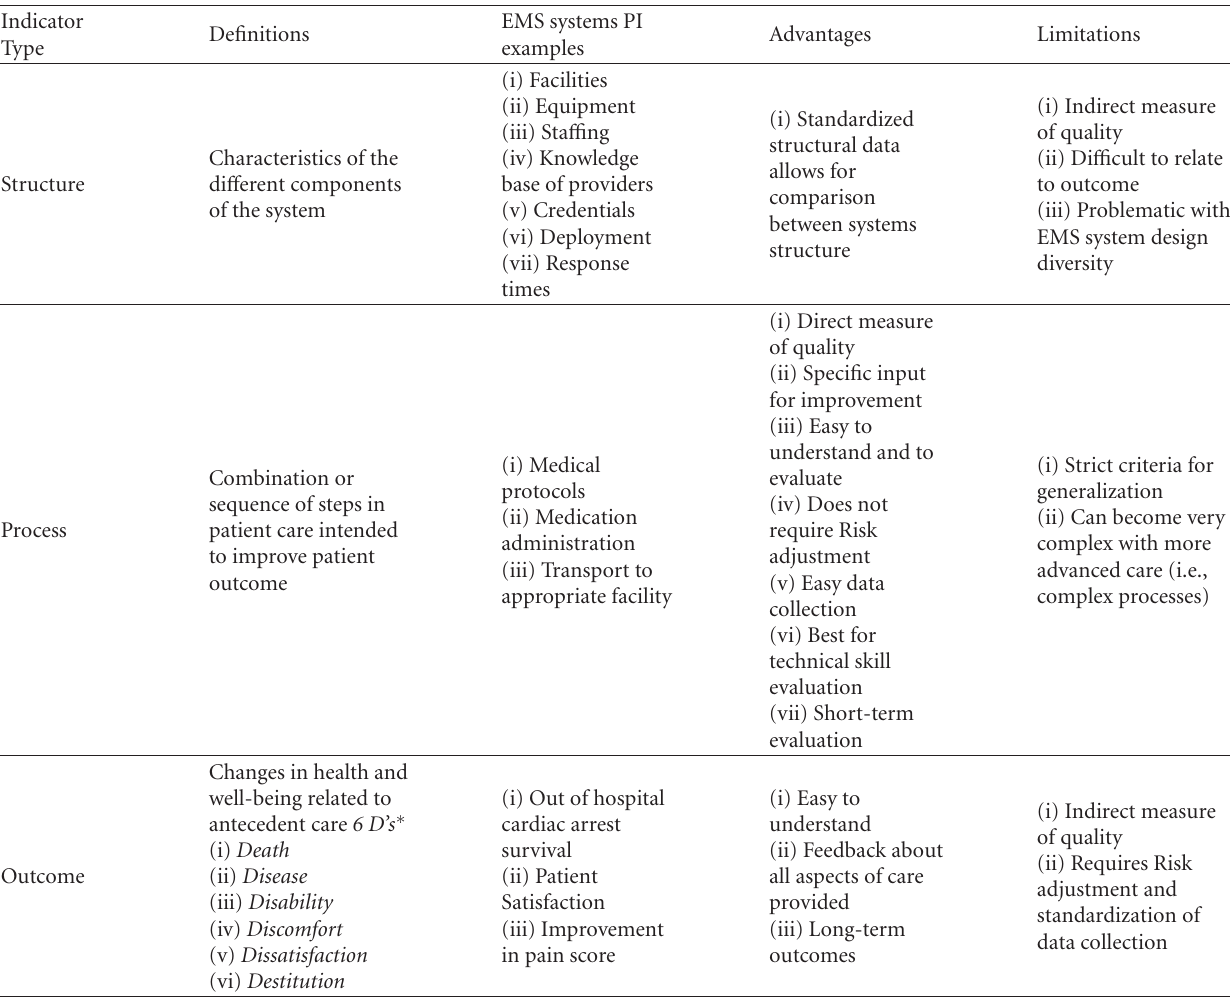
Table 1: Structure-Process-Outcome Model for EMS systems